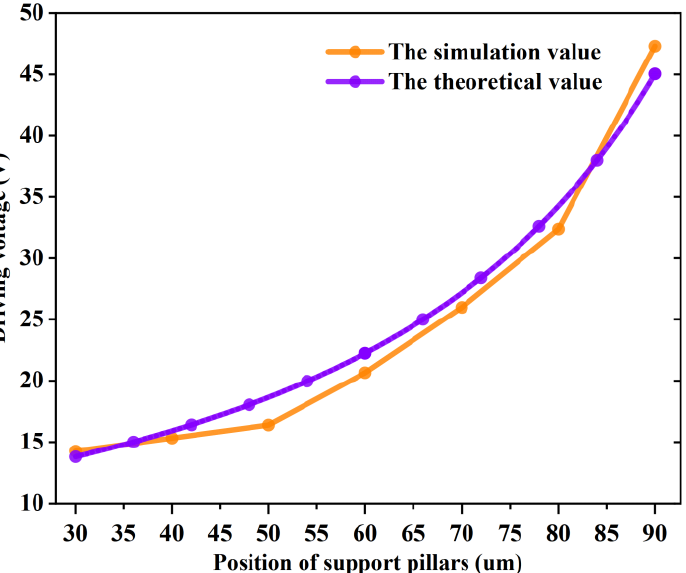
Figure 7. Influence of position of support pillars on pull-in voltage; the black curve is the theoretical value and the red curve is the simulation value.